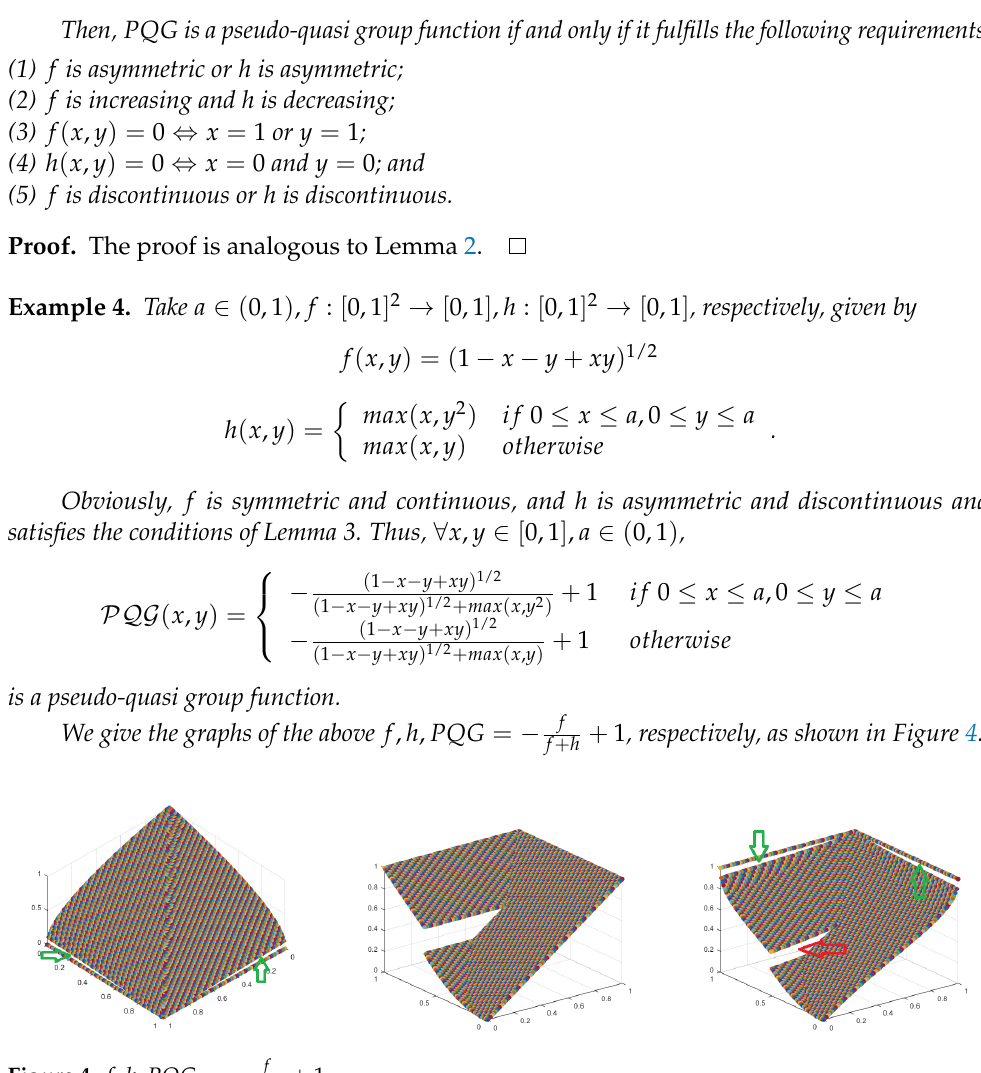
Figure 4. f , h , PQG = − f